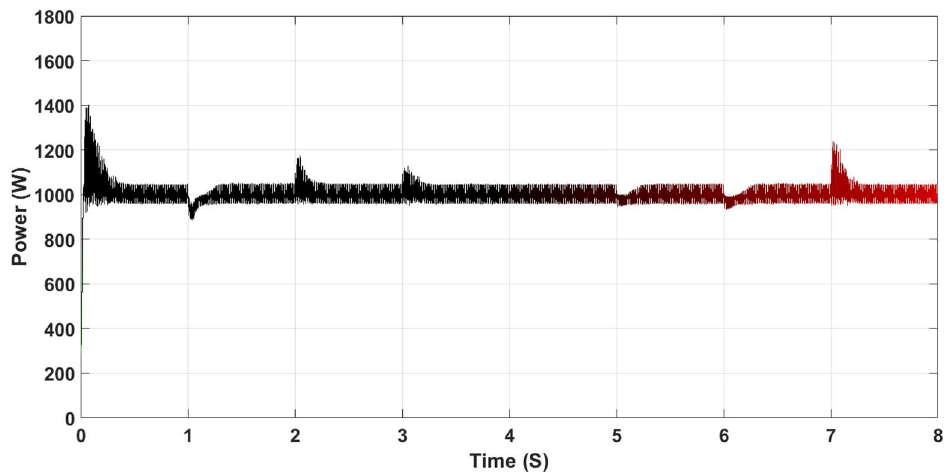
Figure 20. DC grid voltage and power supplied to DC load.